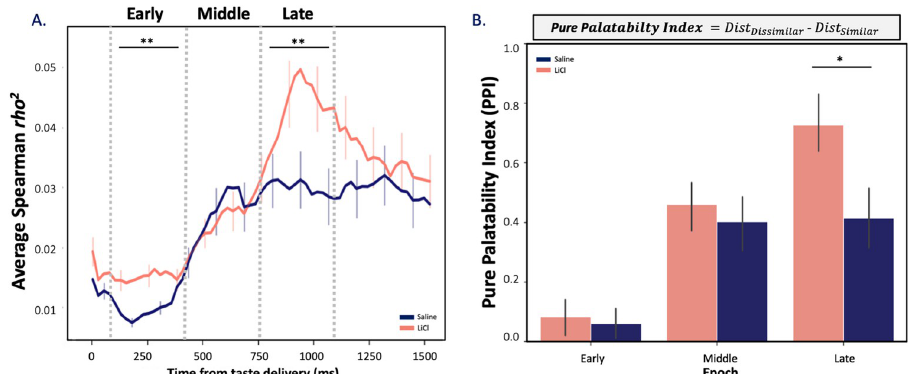
Fig 6. LiCl administration shifts GC taste responses in the direction of a simple “good vs. bad” judgment. (A) The time course of average correlations (Spearman rank-correlation coefficient) between firing rates and known palatability shows the expected increase as responses reached the late epoch, but this rise reached a higher peak following LiCl ( n = 174) than saline injection ( n = 136, Kruskal–Wallis H-test, �� p < 0.01). (B) The sickness-induced reduction of taste discriminability, juxtaposed with this sickness-induced enhancement of palatability-relatedness, suggests that illness selectively decreases the distinctiveness of tastes with similar palatability. As predicted, a PPI, which evaluates this possibility (see inlaid equation), peaks at a larger late epoch value following LiCl injection than following saline (unpaired 2-sample Wilcoxon test; � p < 0.05), reflecting sickness-induced polarization of coding. The error bars represent SEMs. Data underlying this figure can be found in S5 Data. GC, gustatory cortex; LiCl, lithium chloride; PPI, pure palatability index.